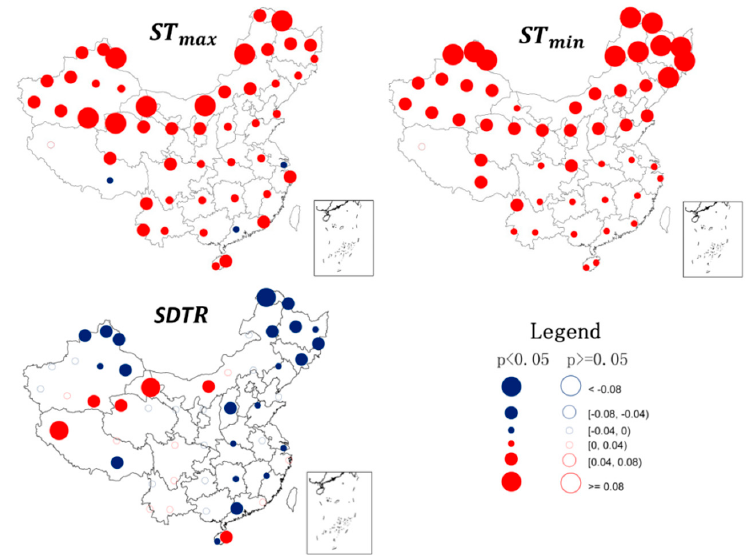
Figure 2. Linear trends and anomalies from annual means of ST max , ST min , and SDTR in China during 1962–2011. Dashed lines are trend lines. K represents the slope (i.e., rate of change (°C/year)); all the slopes of trends were significant ( p < 0.05). Anomaly is the difference between the temperature of one year (corresponding to the X-axis) and the average temperature of 50 years.